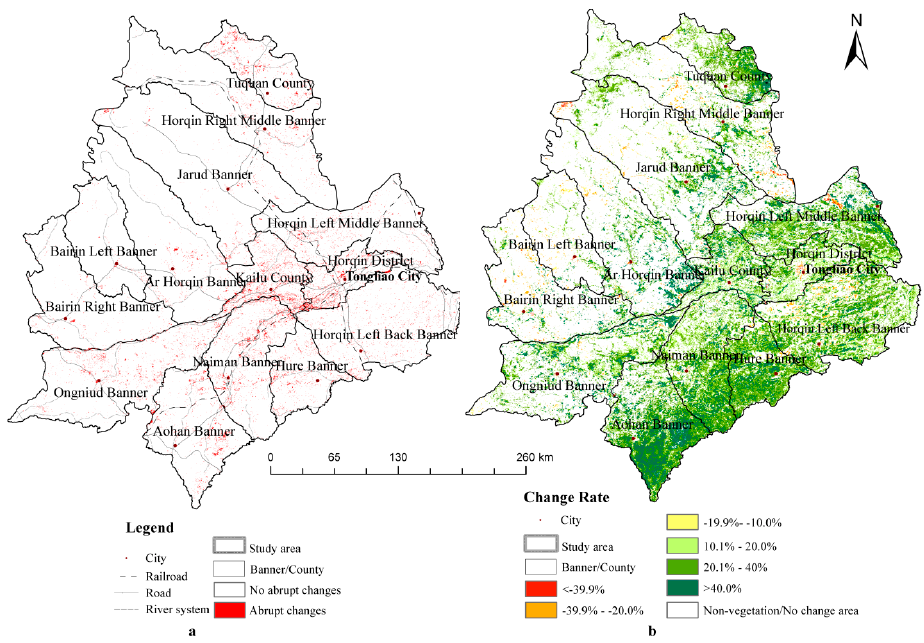
Figure 6. Abrupt change area ( a ); and different trend change rate in study area ( b ).